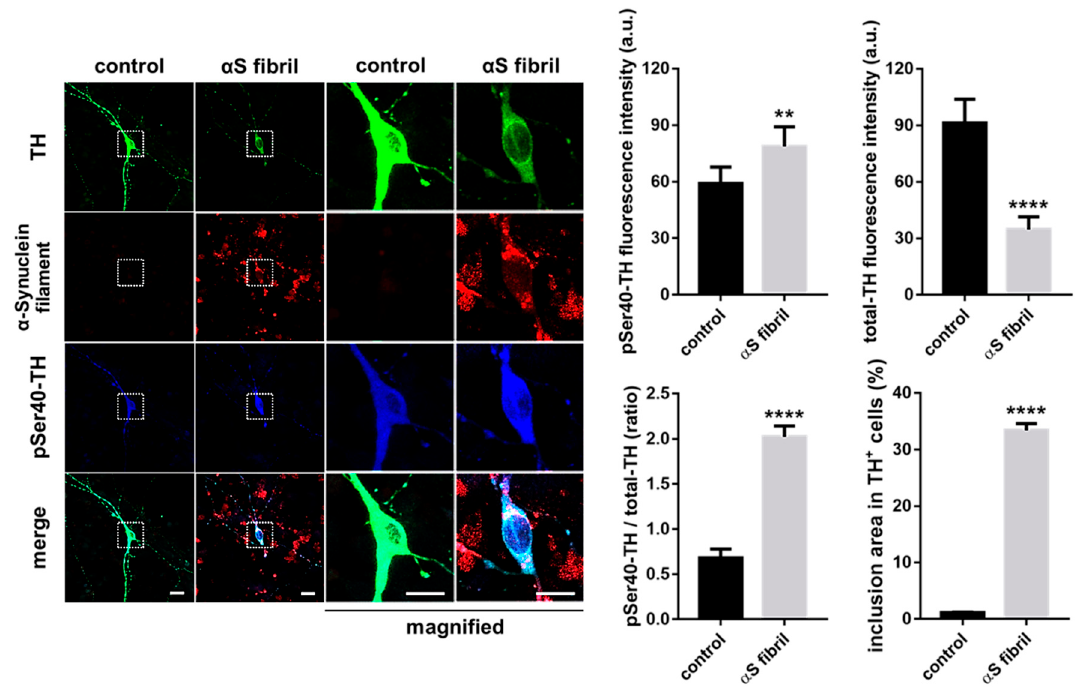
Figure 4. Exposure to α -Synuclein fibrils formed intracellular filamentous inclusions, which was accompanied by the acceleration of TH phosphorylation and the reduction of total TH protein in the cultured dopaminergic neurons in the presence of cycloheximide. Scale bars indicate 10 µ m. The right columns show the quantified data (Student’s t -test, **** p < 0.0001, ** p < 0.01, n > 20). α S indicate α -Synuclein.